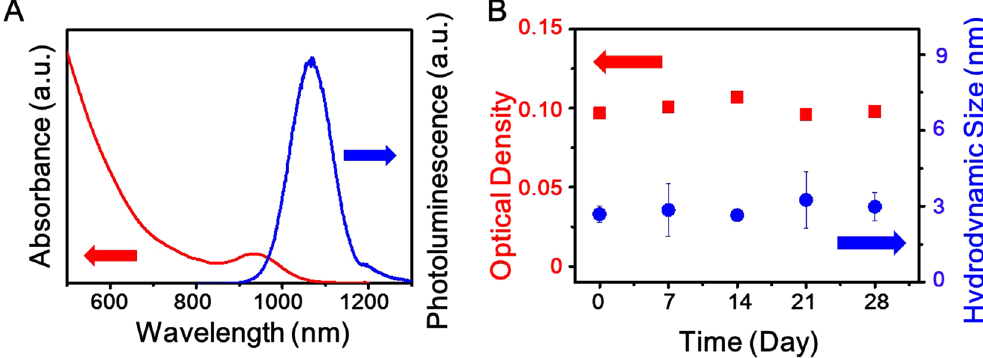
Figure 2. ( A ) Absorption (red line) and photoluminescence (blue line) spectra of PbS QDs-MAPbI 3 dispersed in PC. ( B ) Changes in optical density corresponding to 1 st excitonic peaks (squares) as determined from absorption spectrum (Fig. S3) and hydrodynamic size (circles) as measured by DLS over